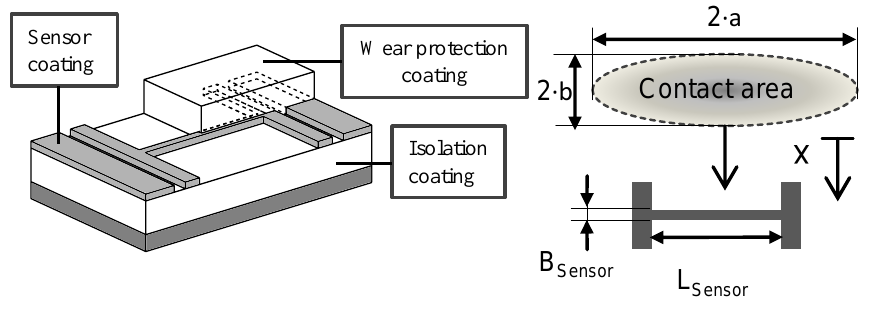
Figure 2. Sensor design.